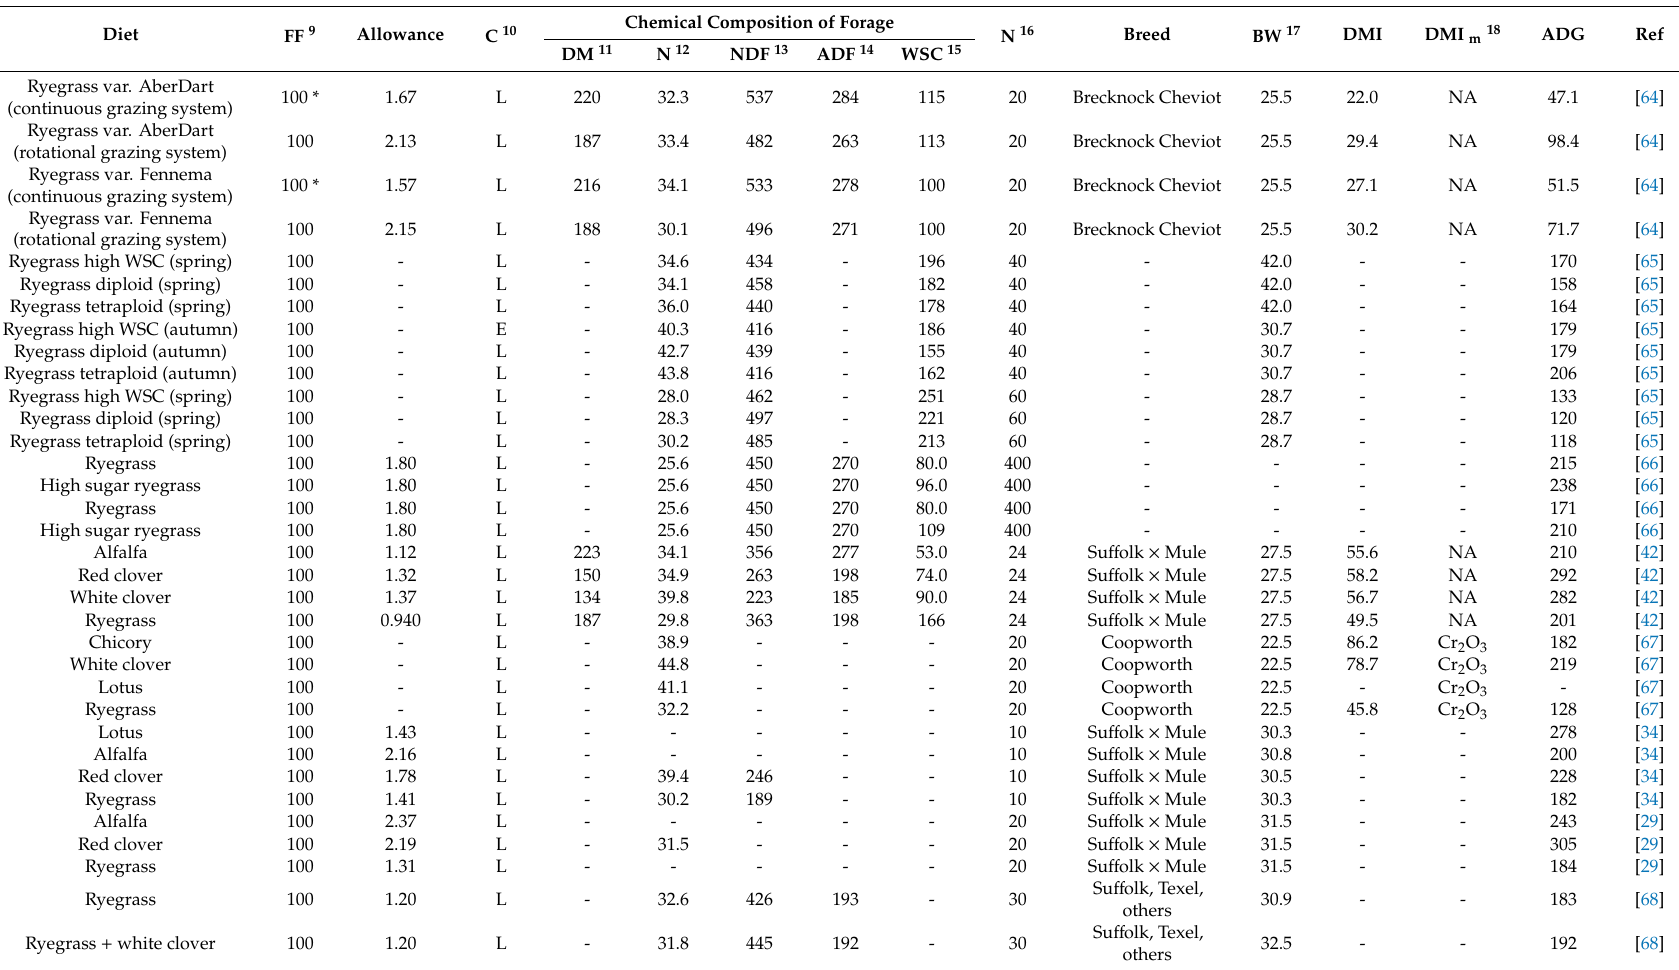
Table 2. Dry matter intake (DMI, g / kg body weight (BW)) and average daily gain (ADG, g / d) of sheep fed fresh forage (FF) or FF plus feedstu ff s (concentrate or total mixed ration, TMR) with di ff erent biomass allowance (t DM / ha) and chemical composition (g / kg